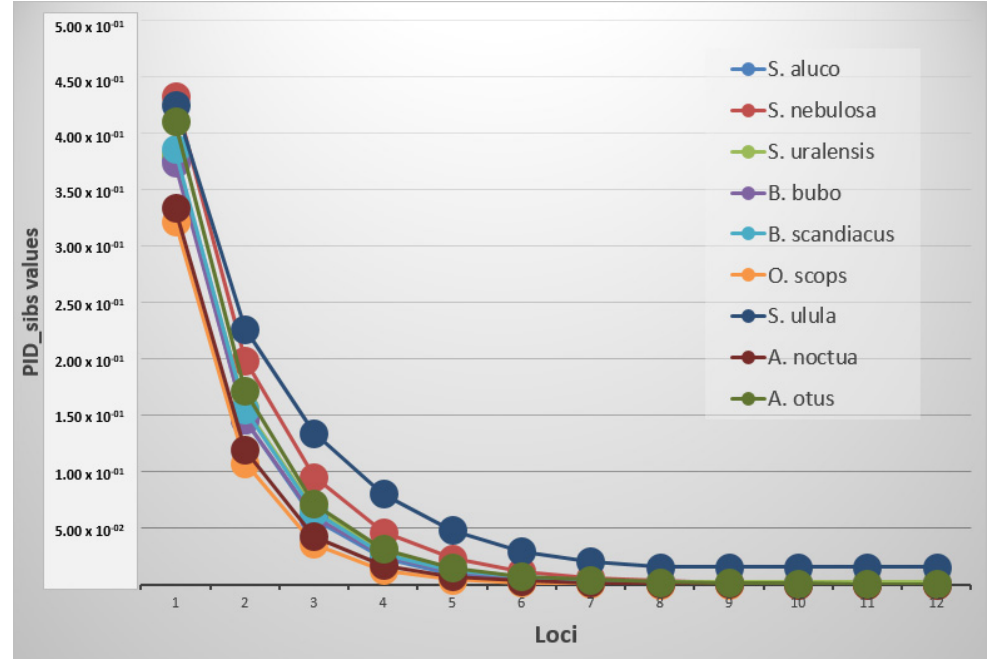
Figure 1. Graph of the PID _sib trend in the species.